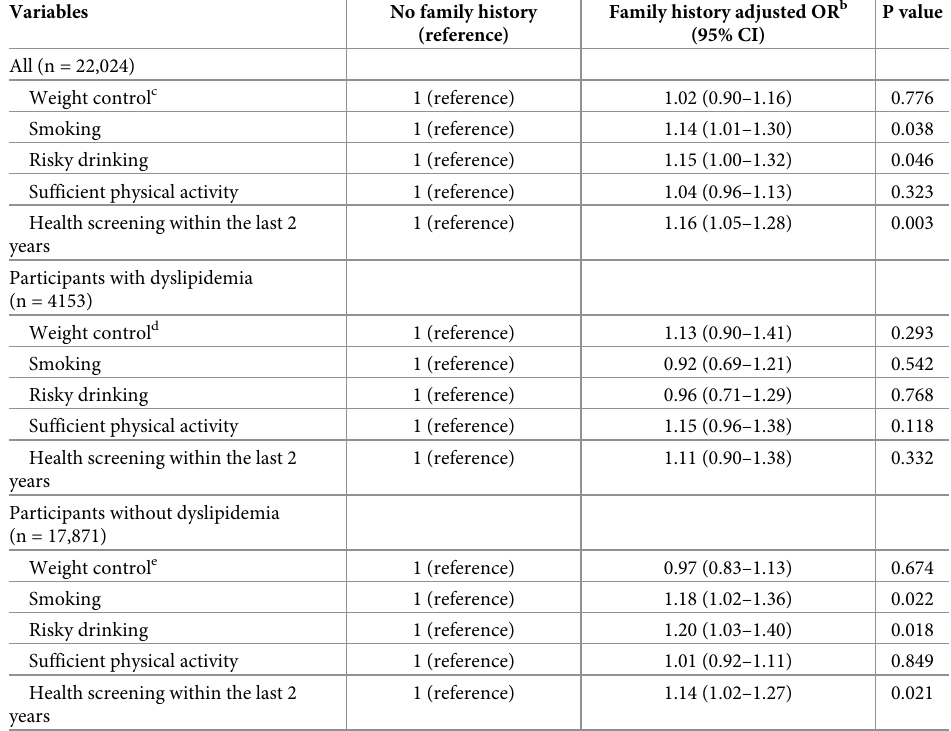
Table 3. Association between family history of cardiovascular disease a and healthy behaviors according to sub- groups of dyslipidemia prevalence.